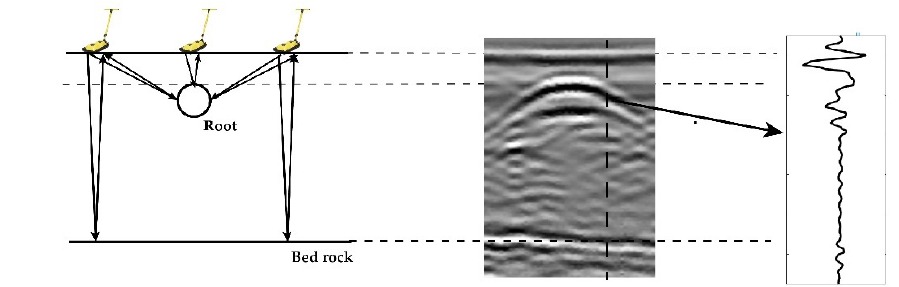
Figure 2. GPR imaging principle.